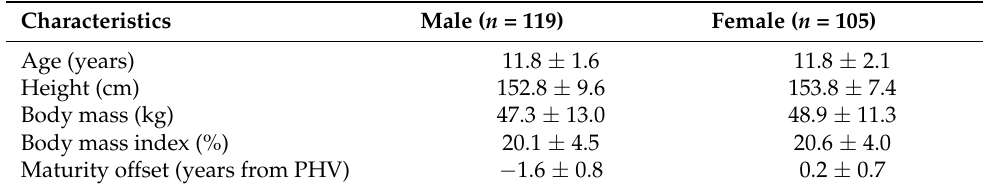
Table 1. Participant